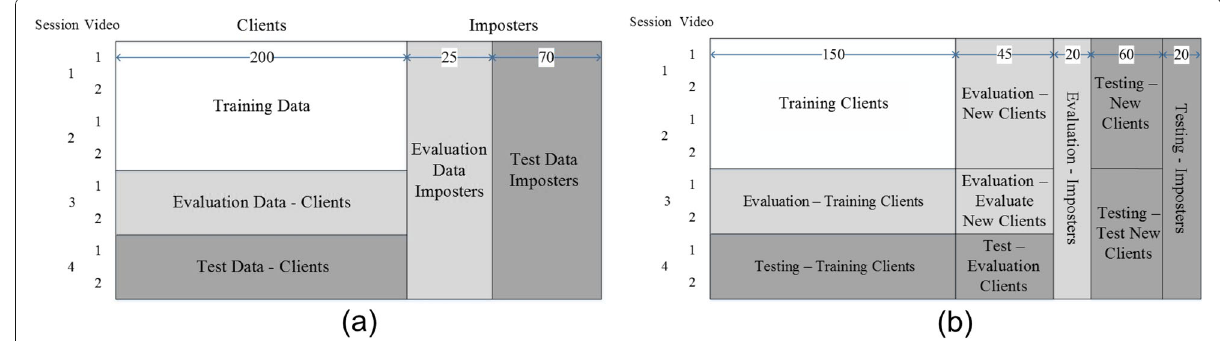
Fig.3 XM2VTSprotocols. a Existingclosed-setLausanneprotocol,configurationII,asdefinedin[21]. b